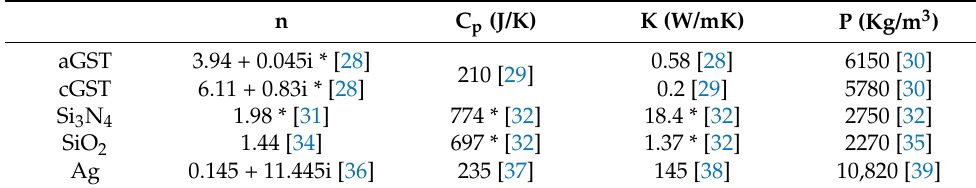
Figure 2. Flow chart of coupling procedure. Table 1. Material parameters list for the device